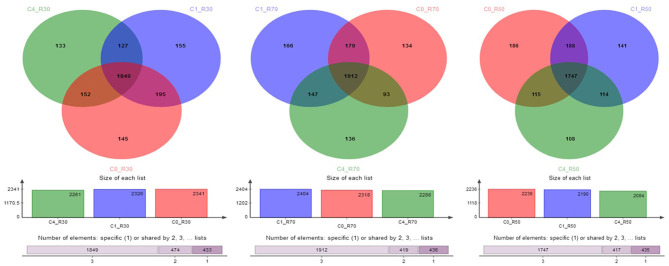
Shared and unique OTUs across groups. C0_R70: control with 70% high roughage; C1_R70: 1% camelina oil level with 70% high roughage; C4_R70: 4% camelina oil level with 70% high roughage; C0_R30: control with 30% low roughage; C1_R30: M1: 1% camelina oil level with 30% low roughage; C4_R30: 4% camelina oil level with 30% low roughage; C0_R50: control with 50% medium roughage; C1_R50: M1: 1% camelina oil level with 50% medium roughage; C4_R50: 4% camelina oil level with 50% medium roughage.